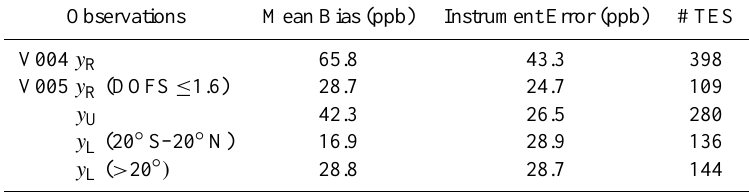
Table 1. TES V004 and V005 Methane Validation Statistics 1 .